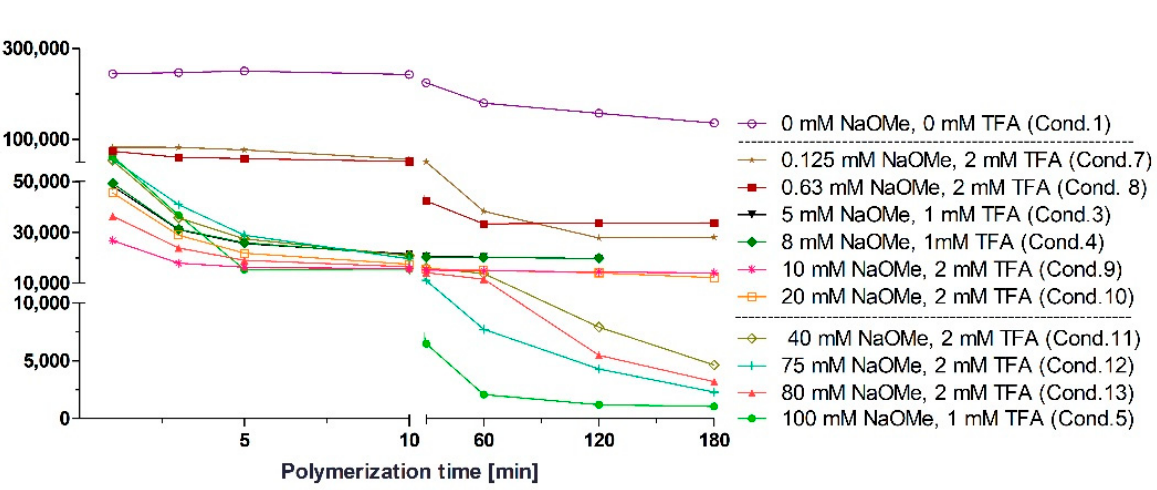
Figure 4. APC™ chromatogram of PBCA at different polymerization time points obtained with 5 mM NaOMe ( A ), 8 mM NaOMe ( B ), 40 mM NaOMe ( C ) and 75 mM NaOMe ( D ).